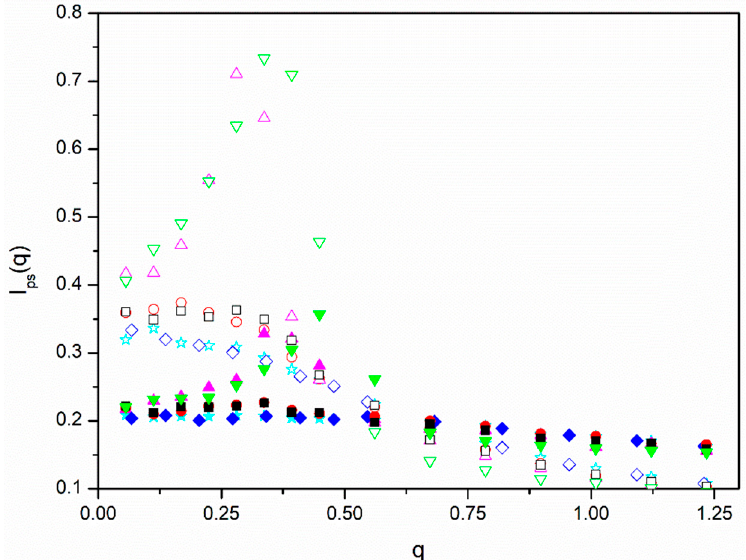
Figure 4. Scattering functions obtained with identical optical contrast factors for A and B units with respect to the solvent, Equation (9), see text, vs. the scattering variable, q , for systems without segregation, ε = 0 case. Blue rhombuses, N = 144, f = 2 ; red circles: N = 145, f = 6; green triangles down: N = 73, f = 12; cyan stars: N = 72, f = 2 ; black squares, N = 73, f = 6; magenta triangles up: N = 145, f = 12 . Filled symbols correspond to Φ ≅ 0.275 and open symbols correspond to Φ ≅ 0.135.